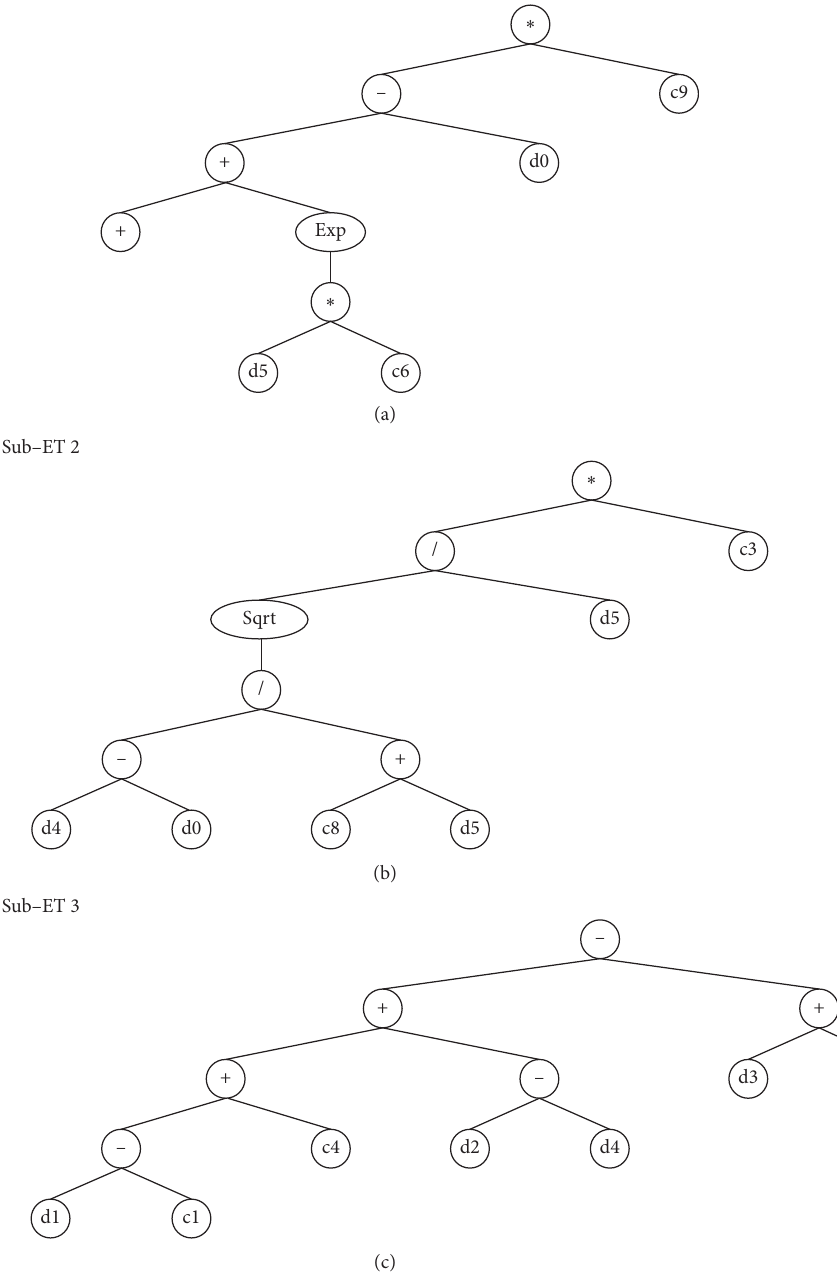
Figure 8: Expression tree of the model formulated for UCS (where d0: HARHA, d1: w